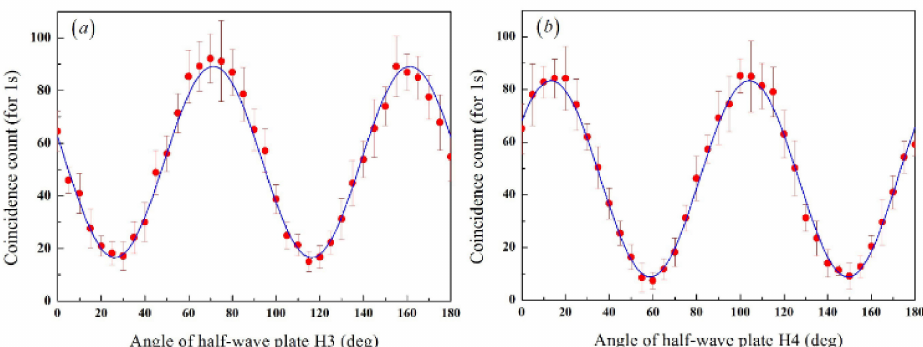
Figure 4. Coincidence counts of the quantum three-pass protocol. The red plots indicate the average of the coincidence counts for one second. The red bars indicate the standard deviation of the coincidence counts for each point. The blue solid line indicates the sine curve fitted to the data. ( a ) Test for QMAC generation and recovery. ( b ) Test for Bob’s encryption and